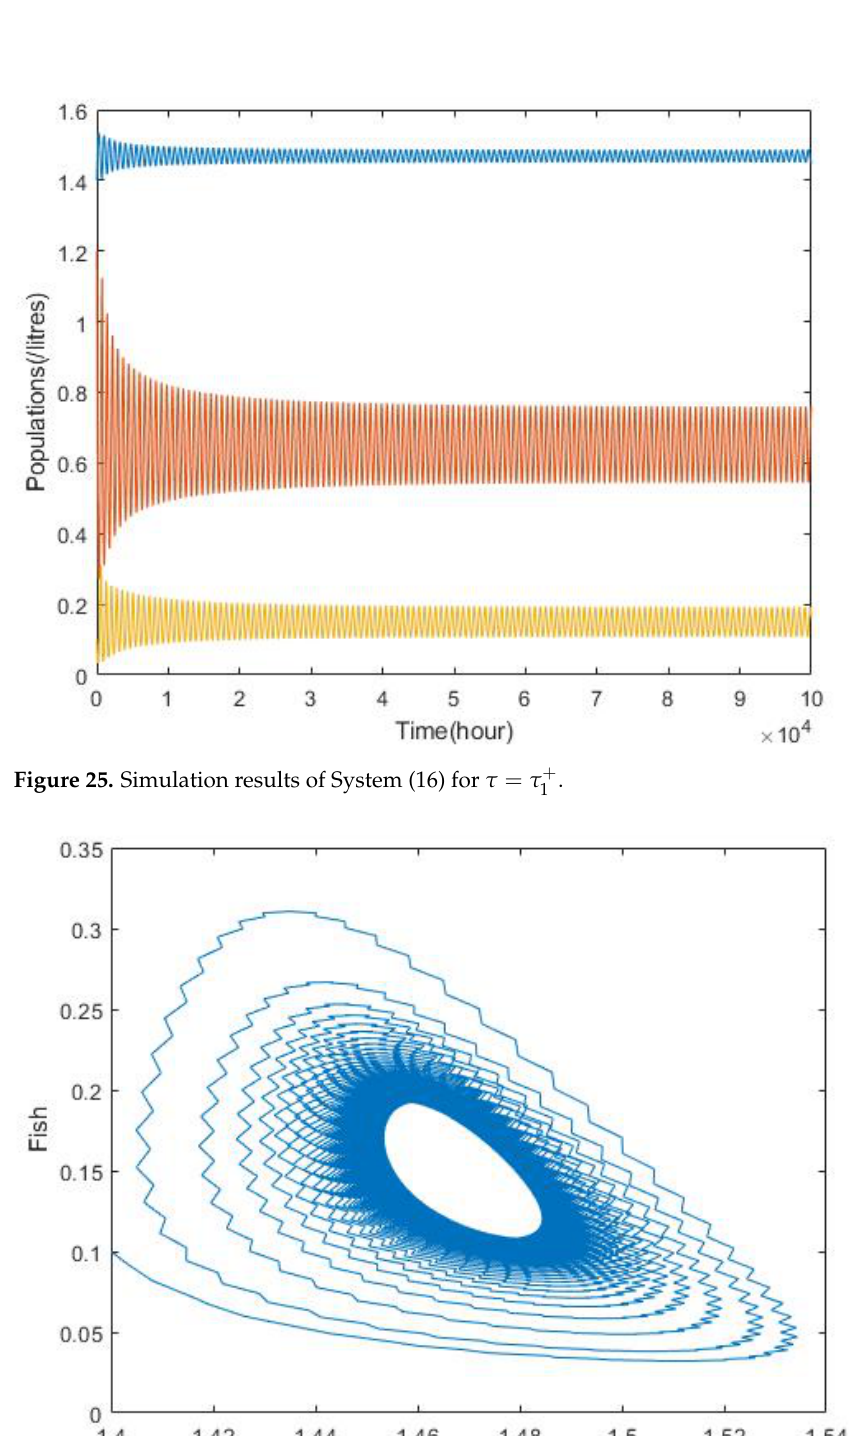
Figure 26. Equilibrium between the TPP and fish populations loses its stability for τ = τ +